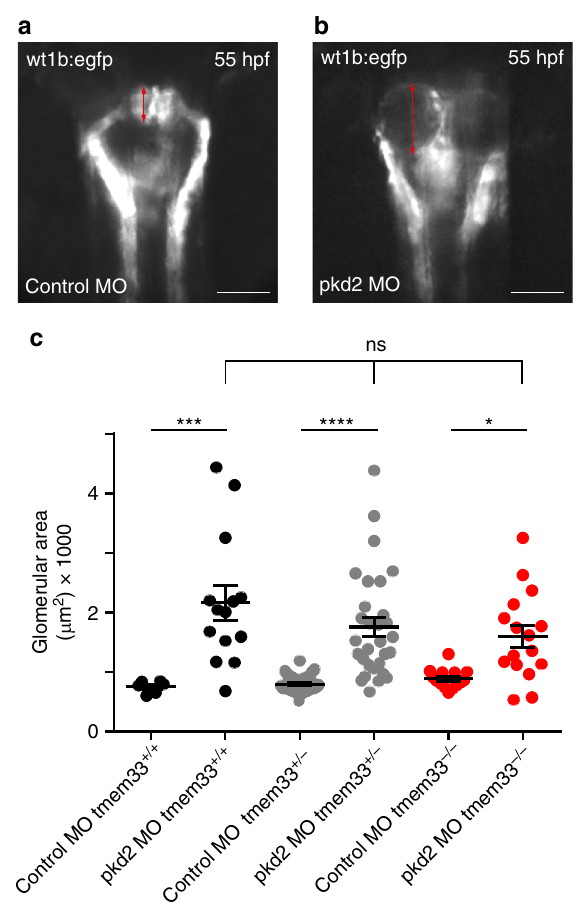
Fig. 8 Tmem33 does not in fl uence renal cystogenesis in zebra fi sh. a Epi fl uorescence image of zebra fi sh glomeruli. Control morpholino oligomer injected in Tg(wt1b:EGFP) li1 . b Morpholino knockdown of pkd2 increases glomerular area in Tg(wt1b:EGFP) li1 (red arrows). Scale bars: 50 µ m. c Pkd2 -dependent renal cystogenesis was unaffected by the loss of tmem33 in zebra fi sh tmem33 sh443 mutants (tmem33 + / + black dots, tmem33 + /- gray dots and tmem33 − / − red dots). Each data point refers to a single glomerulus. Values are means ± SEM overlaid with dot plots. One way ANOVA with Turkey ’ s post hoc * p < 0.05, *** p < 0.001, **** p <